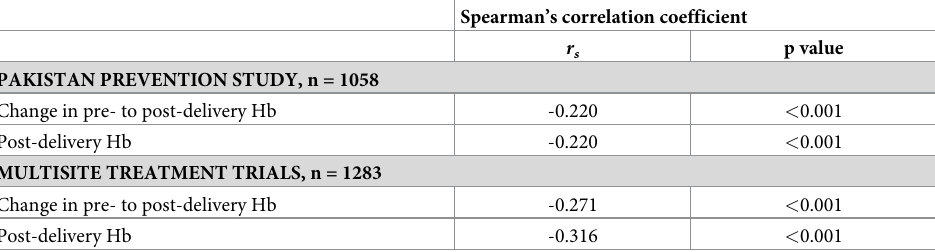
Table 2. Correlation of postpartum blood loss with change in pre- to post-delivery hemoglobin and postpartum